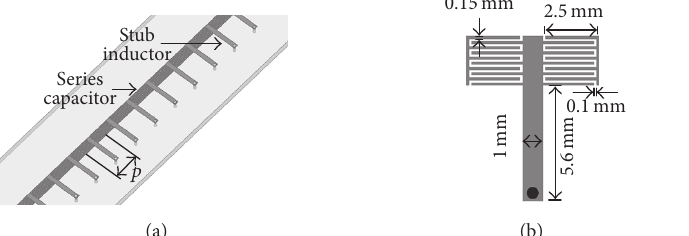
Figure 2: CRLH TL structures. (a) Periodic CRLH TLs with series capacitors and shunt stub inductors. (b) Geometry of unit cell of CRLH TL.